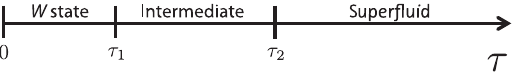
FIG. 2. Phases of the ABH as a function of the parameter (cid:4) (cid:1) 0 : 25 is approximately independent of lattice ). (cid:4) ( (cid:4) ¼ j (cid:2) j (cid:1) ð N (cid:4) 1 Þ 1 (cid:7) (cid:4) ( (cid:4) ) is a function of M , as delineated in the size, while (cid:4) 2 2 1 text and plotted in Fig. 3.